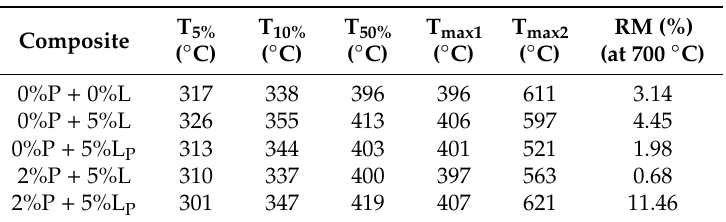
Figure 8. TG ( A ) and DTG ( B ) curves of the studied composites. Table 4. TG / DTG